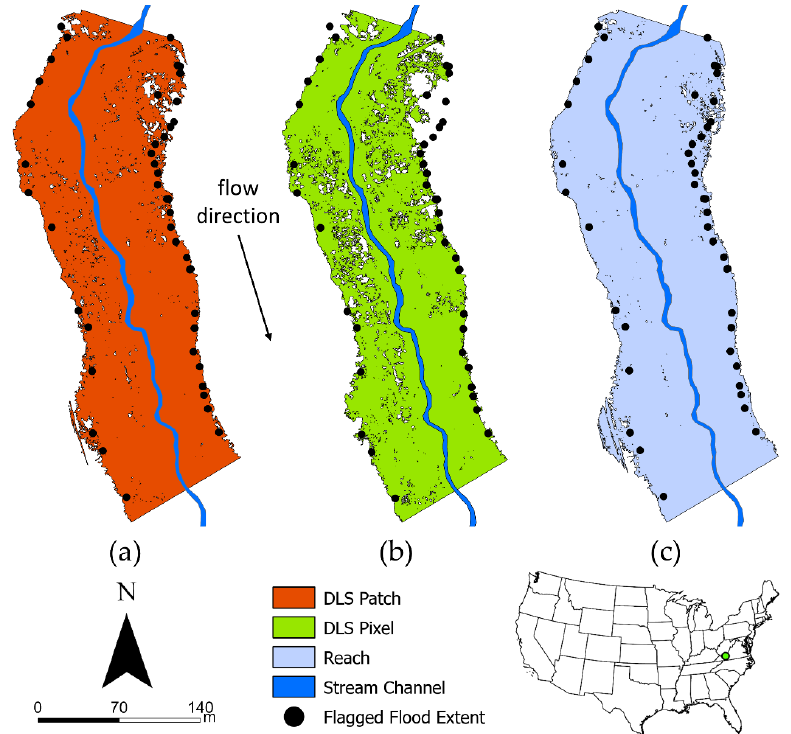
Figure 8. Flagged flood extent on 11 October 2018 compared to modeled flood extents from: ( a ) DLS patch, ( b ) DLS pixel, and ( c ) reach methods. The results using the SfM patch and pixel methods are not shown since there was little difference between the DLS and SfM models.